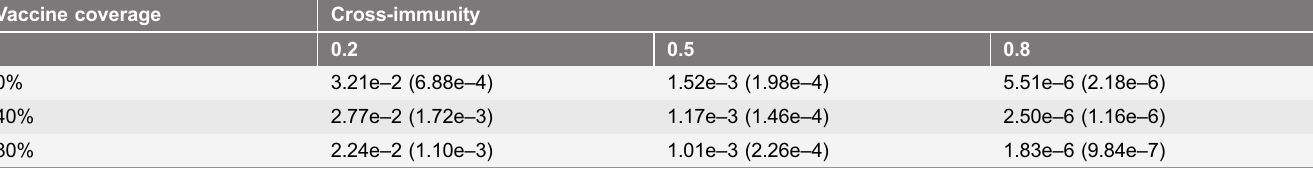
The average probability of pandemic emergence and its standard deviation (in parenthesis) are obtained from ten million realisations of the dynamics processes within one year period since the introduction of the second endemic strain into a population at endemic with strain 1. Here we consider the special situations where vaccination and primary infection induce the same levels of cross-immunity against endemic and reassortant strains (i.e. Q 5 y 5 Q V 5 y V ). The values of other model parameters are as in Table 1. The table shows that the levels of cross-immunity heavily control the effectiveness of vaccination while the vaccine coverage plays a much weak